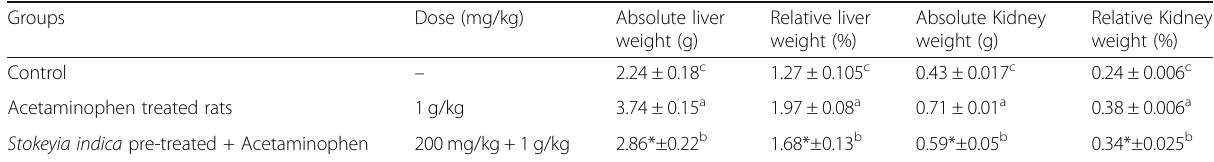
Table 1 Absolute weights (g) and relative weights (%) of liver and kidney tissues in different groups of rats Groups